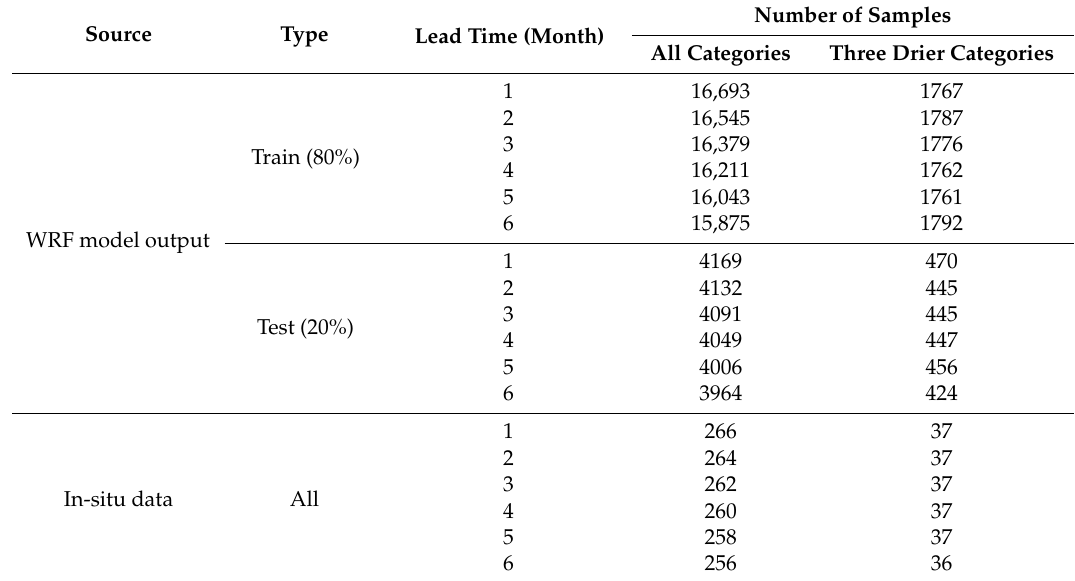
Table 3. Numbers of data samples used for training and testing.